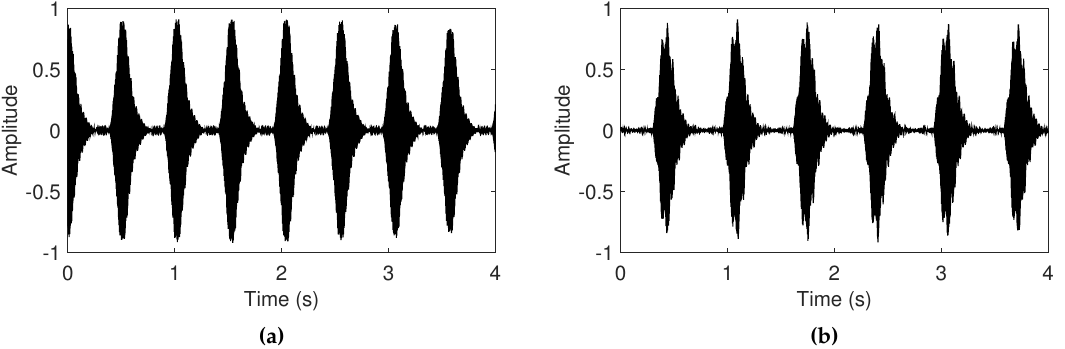
Figure 4. Simulated tempo-scale effects of feedback sounds when length of the delay line is ( a ) 22,000 samples (2 Hz) and ( b ) 28,500 samples (1.55 Hz). The signals are normalized to compare the tempo-scale periodic occurrences of the Larsen tones, depending on delay line